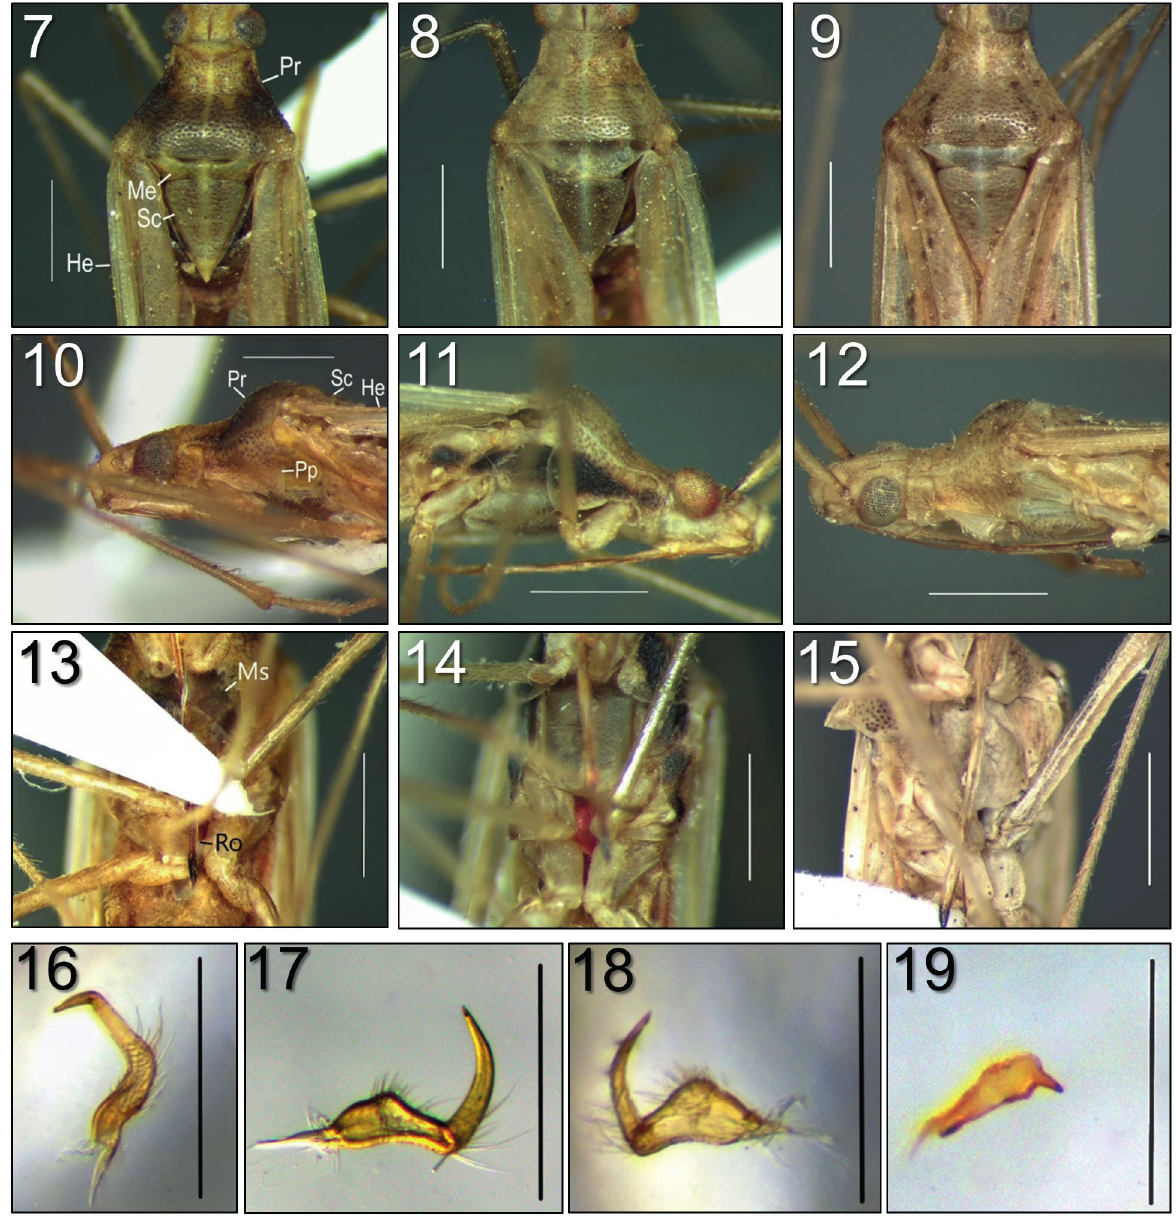
Figures 7-19 - S. longicuneata , pronotum, mesoscutum, scutellum and hemelytra (7-9) . propleura ( 10-12 ) mesosternum ( 13- 15 ) left paramere dorsal view ( 16 ) left paramere external view ( 17 ) left paramere internal view ( 18 ) right paramere dorsal view ( 19 ). Scale bars: 1mm (Figs 7-15), 0,5mm (Figs 16-19). Hemelytra (He); Mesoscutum (Me); Mesosternum (Ms); Pronotum (Pr); Propleura (Pp); Rostrum (Ro); Scutellum